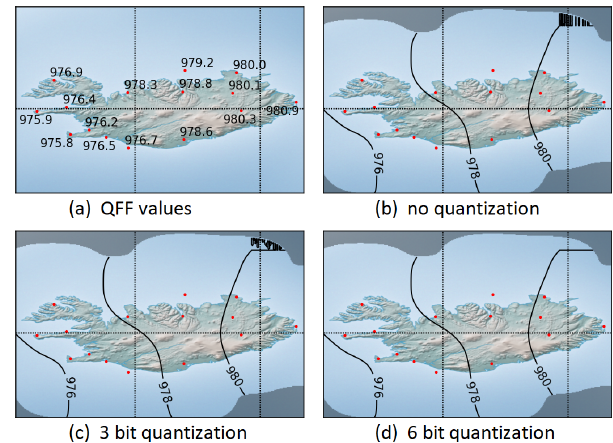
Figure 14. Constellation of QFF values over Iceland with generated isolines for σ = 0 . 75 ◦ . Note the 980.0hPa observation value in the northeast of Iceland, which triggers the creation of the faulty isoline for the same value. By increasing the quantization degree of the resulting field values, the visual appearance is gradually